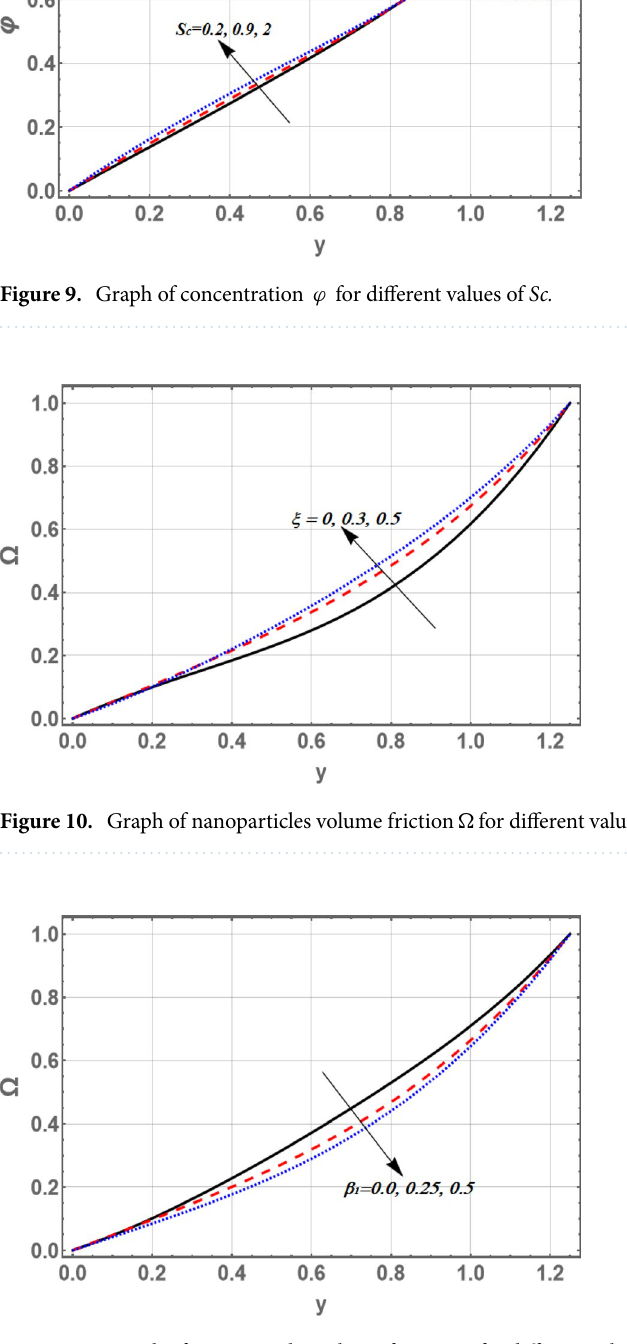
Figure 11. Graph of nanoparticles volume friction (cid:31) for different values of β 1